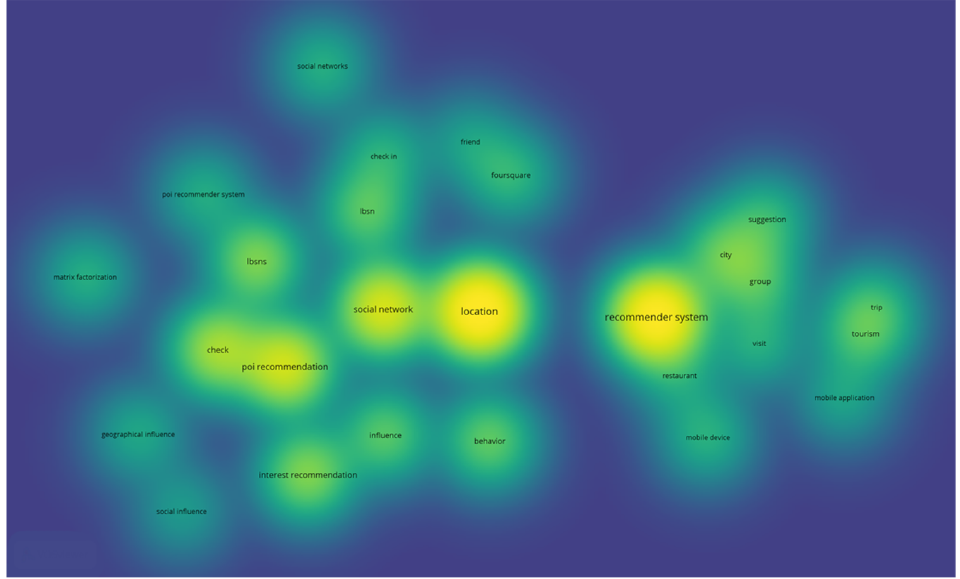
Figure 1. Network visualization for the POI recommendation keywords with VOSviewer.